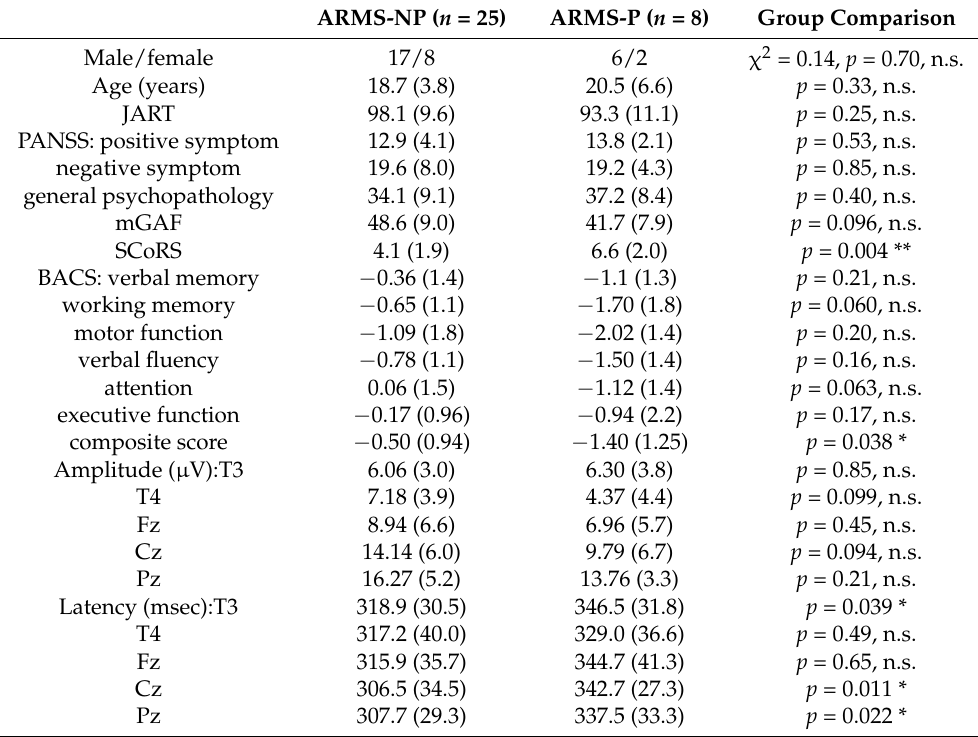
Table 2. Demographic data, cognitive functions and P300 parameters in clinical high-risk